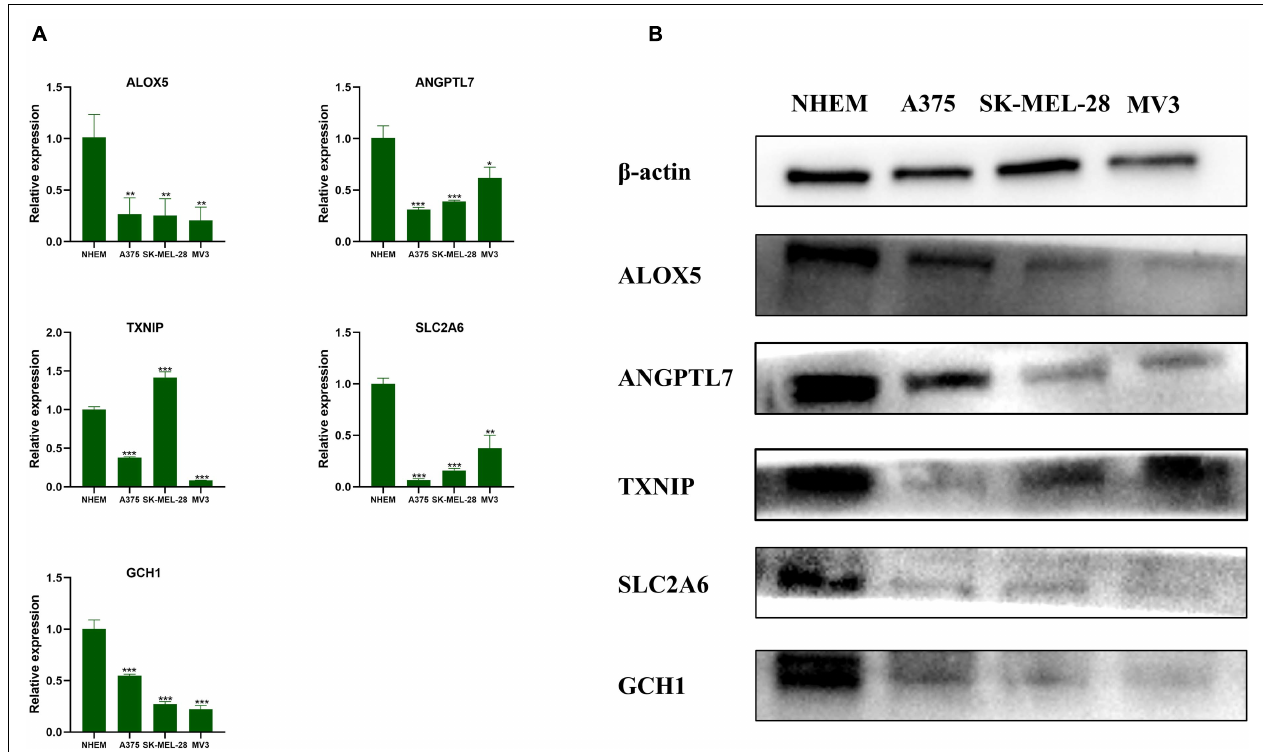
FIGURE 8 | Validation of the genes by qRT-PCR and Western blot. (A) The relative mRNAs expression levels of ALOX5, ANGPTL7, TXNIP, SLC2A6, and GCH1 were presented by RT-qPCR. Data are shown as mean ± standard deviations, n = 3; * p < 0.05; ** p < 0.01; *** p < 0.001. (B) The relative protein expression levels of ALOX5, ANGPTL7, TXNIP, SLC2A6, and GCH1 are presented by Western blot.